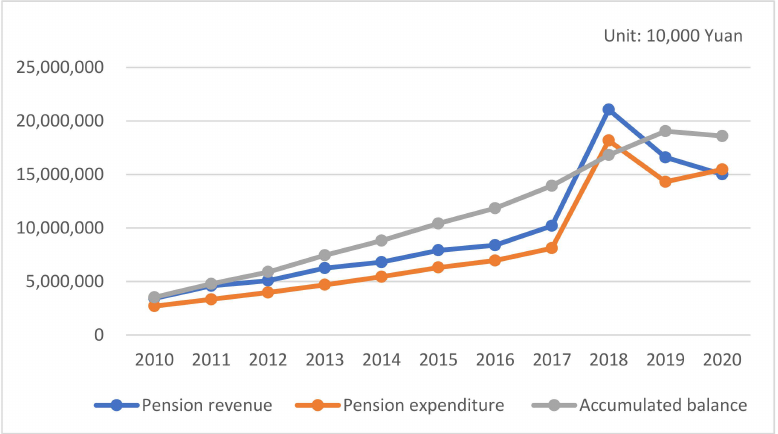
Figure 1. The revenue and expenditure of pension accounts in Anhui Province from 2010 to